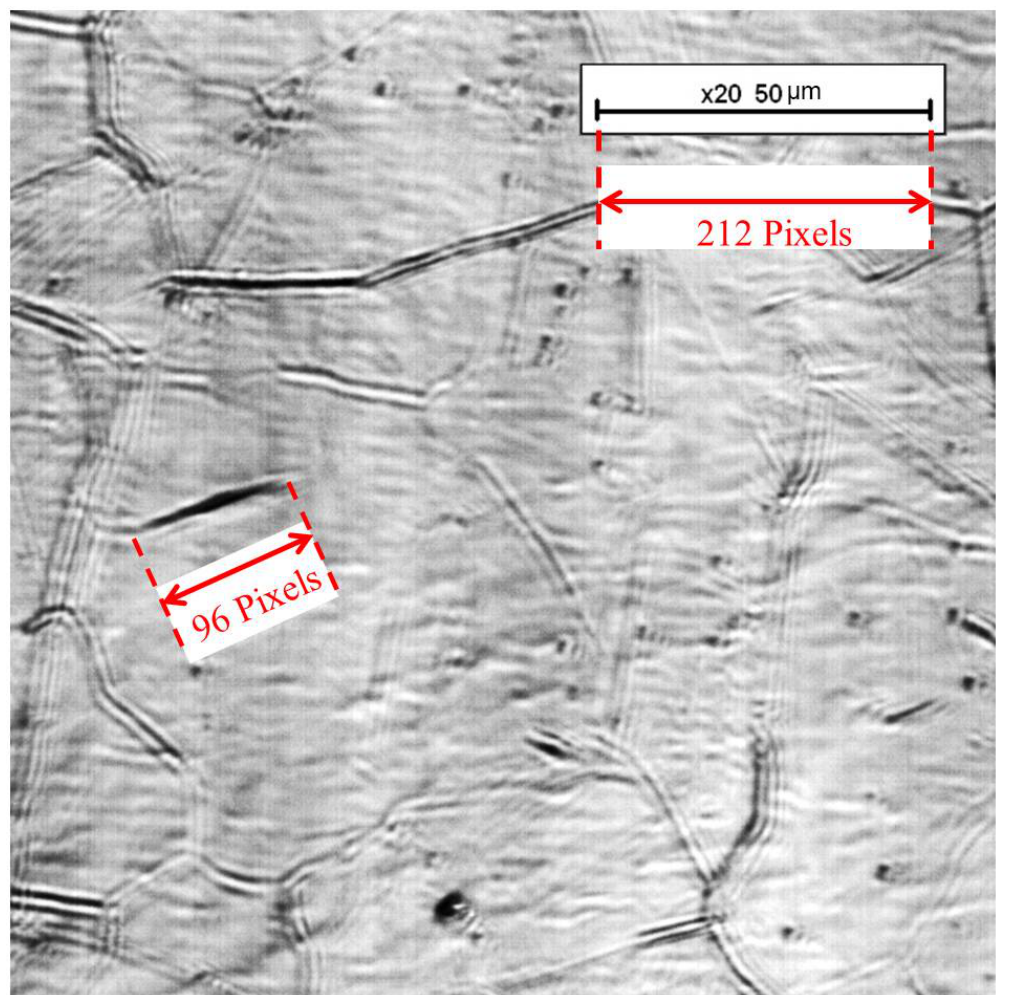
Figure 1. Demonstration of MATLAB’s image viewing toolbox imtool for estimating the μm equivalent of pixel measurement according to the scale bar and measuring length of the ferrite plate (unit of measurement in pixels).